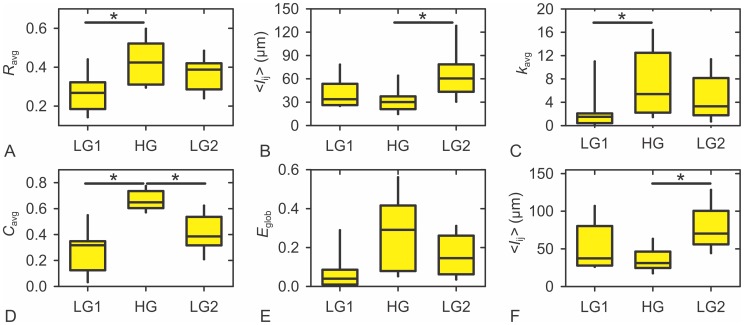
Characteristics of functional networks of beta cells in 9 islets of Langerhans for three of the five regimes analyzed.
A The average correlation coefficient. B The average physical distance between connected cells. C The average node degree. D The average clustering coefficient. E The global efficiency. F the average lengths of connections originating from 20% of the cells with the highest degree. In all panels red circles denote the median values, whereas the yellow floating columns signify the broadness of intervals within which the values were detected in all 9 islets. Significant differences obtained after pairwise post hoc Wilcoxon signed-rank tests are indicated by asterisks.